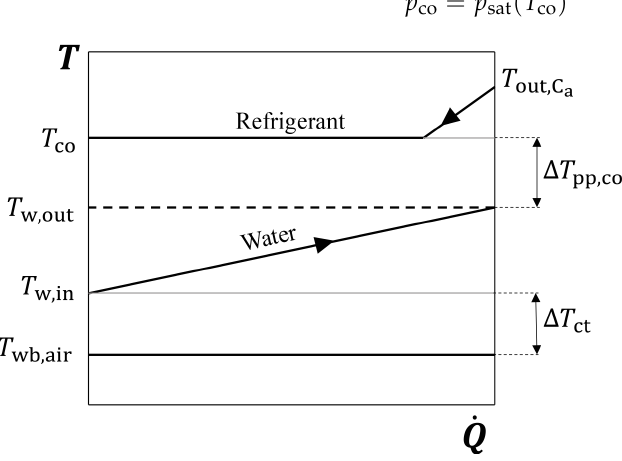
Figure 3. Water-refrigerant heat exchange